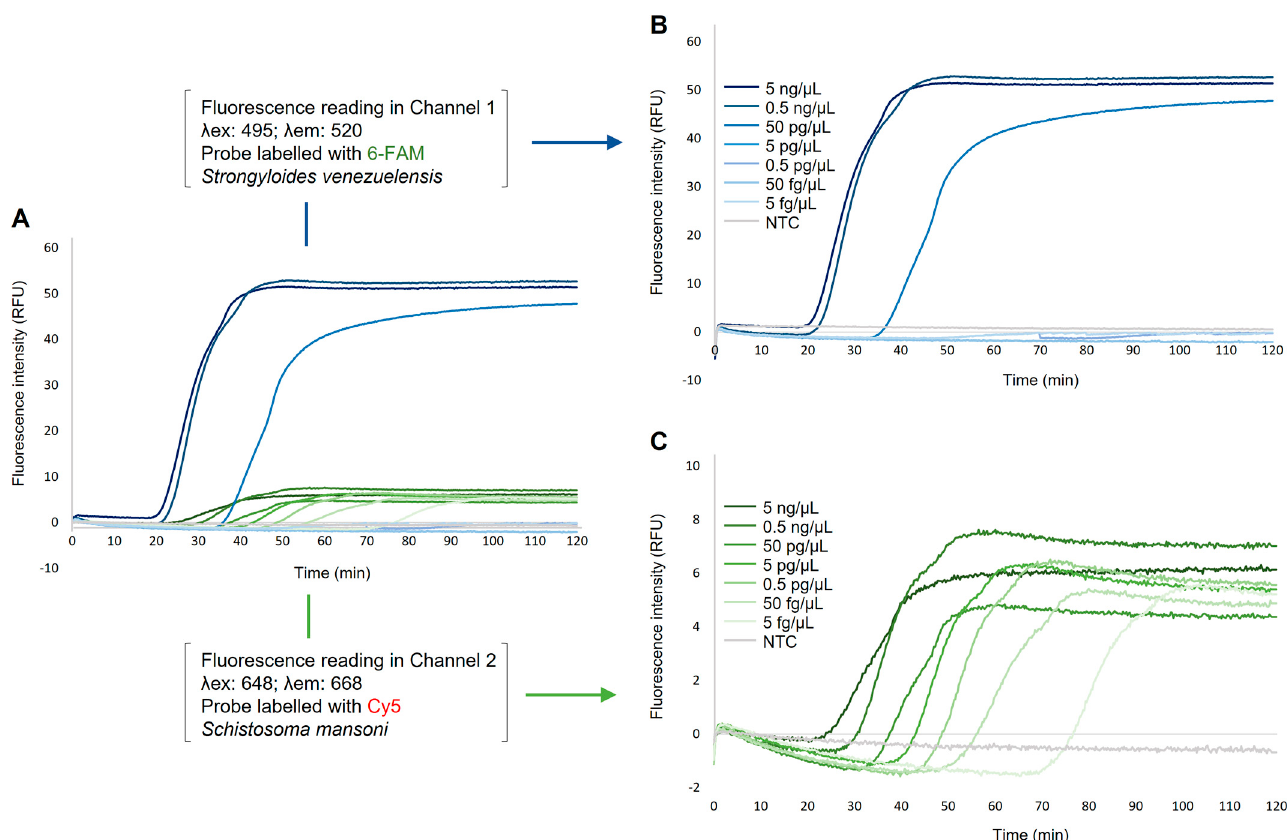
Figure 4. Sensitivity assessment of duplex DARQ-LAMP assay using the Genie III handheld device. ( A ) Analytical sensitivity for simultaneous detection of Schistosoma mansoni gDNA and Strongyloides venezuelensis gDNA using 10-fold serial dilutions. ( B ) Analytical sensitivity for S. venezuelensis in duplex DARQ-LAMP reaction. Only the excitation ( λ ex = 495) and emission ( λ em = 520) channel 1 for fluorescence measurement of 6-FAM is represented. ( C ) Analytical sensitivity for S. mansoni in duplex DARQ-LAMP reaction. Only the excitation ( λ ex = 648) and emission ( λ em = 668) channel 2 for fluorescence measurement of Cy5 is represented. The 10-fold serial dilutions (5 ng/µL to 5 fg/µL) of gDNA from parasites are represented by different shades of blue (for S. venezuelensis ) and green (for S. mansoni ). NTC, non-template control (ultrapure water instead gDNA) is represented by grey lines in both cases. RFU, relative fluorescence units.